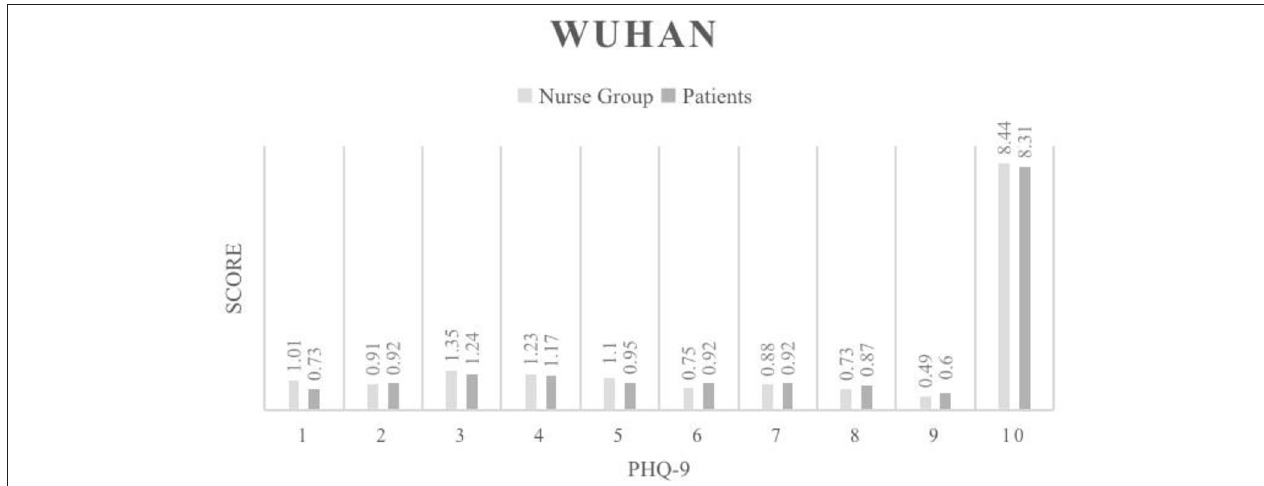
FIGURE 1 | PHQ-9 Phq-9 score results for the Wuhan